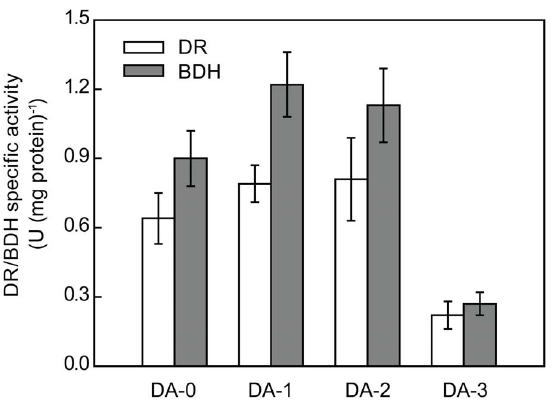
Figure 4. Comparison of DR and BDH activities in the engineered strains and control strain. The activities of DR and BDH were determined in cells at mid-log growth phase of batch-flask fermentation. The mean values of three independent experiments are shown. The error bars indicate the respective standard deviations.